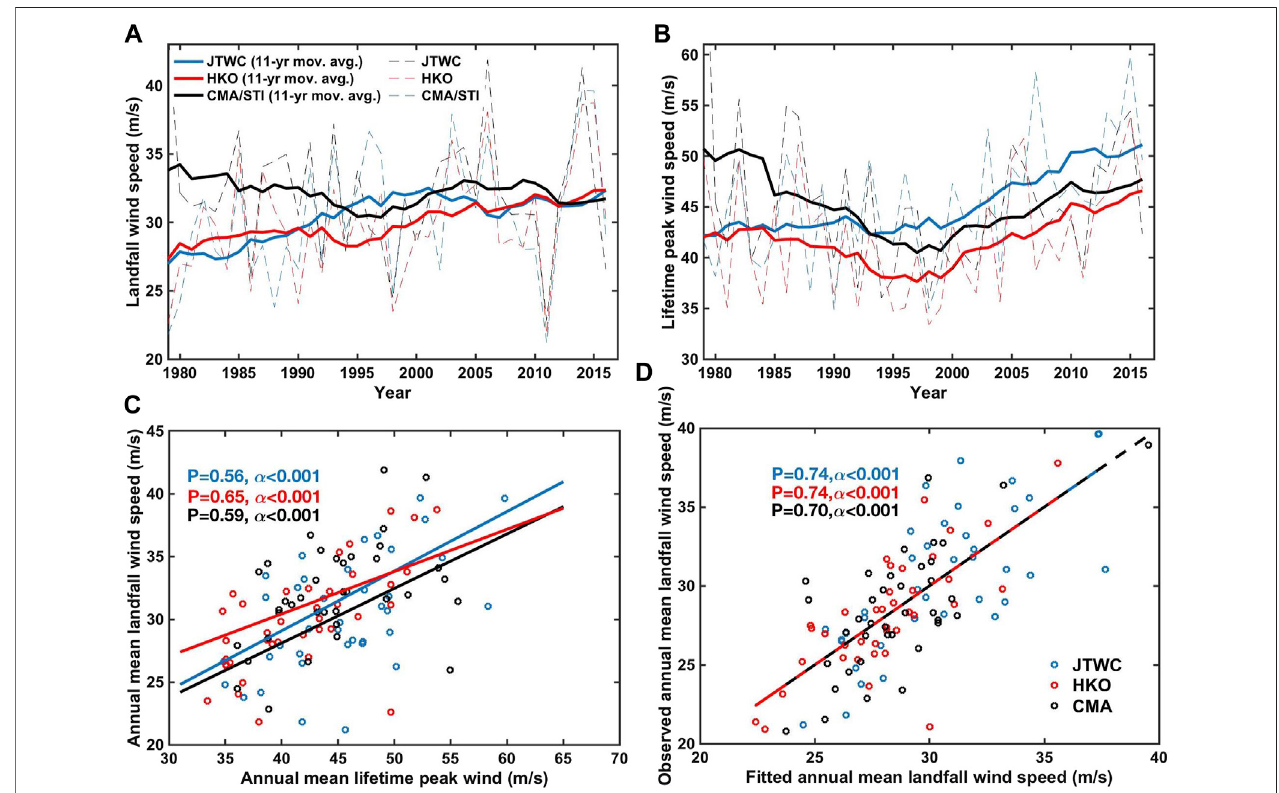
FIGURE3|(A,B) arethe annual meanofTClandfallintensityand lifetimepeak intensity, respectively; (C) illustrates thescattering plotofannual mean lifetime peak intensity and landfall intensity from different datasets, while (D) represents relationship between the annual mean observed landfall wind speed and the landfall wind speed fi tted from lifetime peak intensity and D pl . Data are from JTWC, CMA/STI, and HKO.